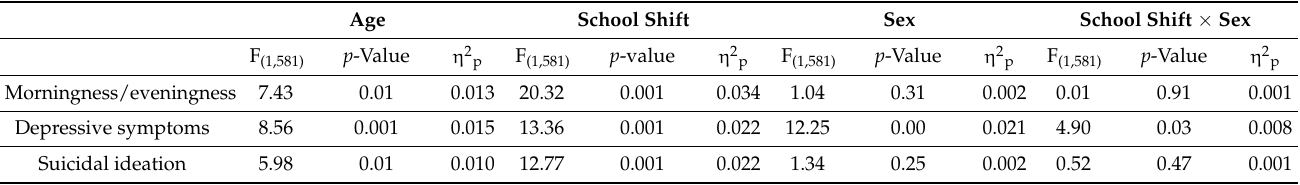
Table 4. Statistical data (F, p -value, and partial eta square) on morningness/eveningness, symptoms of depression, and suicidal ideation according to school shift and sex (age as a